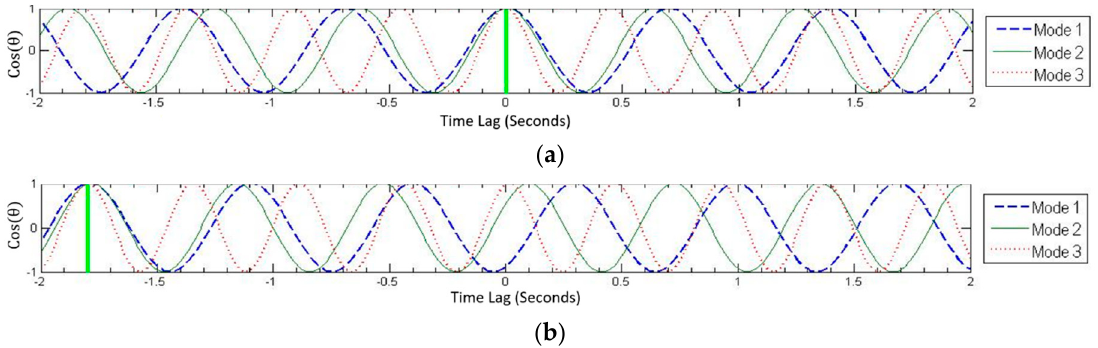
Figure 7. Phase angle as a function of time lag (PATL) plots for node #2 for first three modes. Synchronized dataset ( a ) and de-synchronized dataset ( b ).